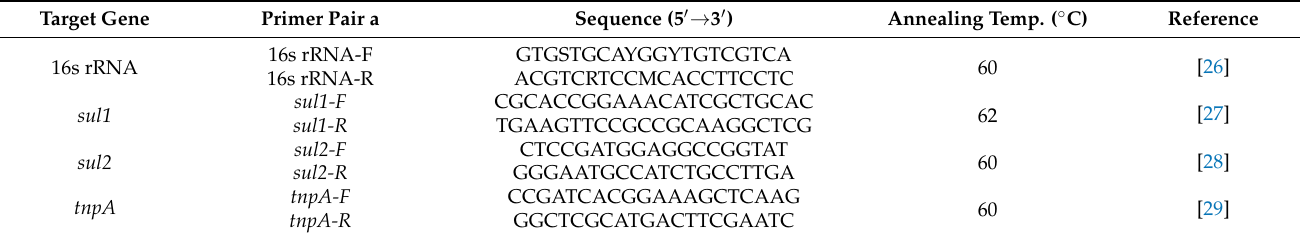
Table 1. Primers employed in the present study for real-time quantitative